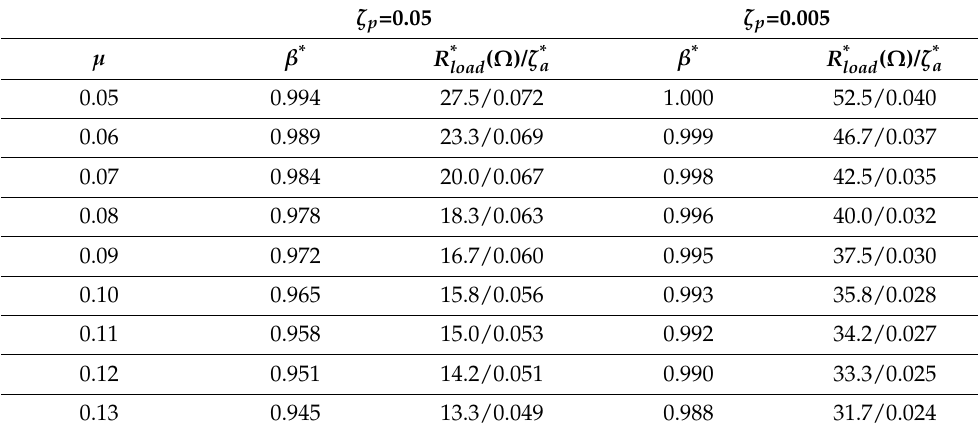
Table 4. The optimum parameters for EH when ζ p = 0.05.